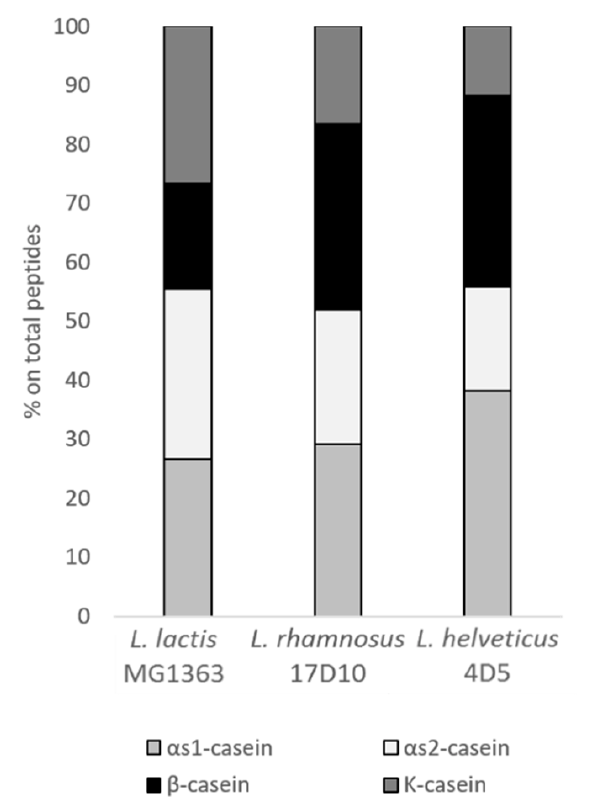
Figure 3. Percentage of casein-derived peptides harvested in the late exponential phase of L. lactis MG1363, L. rhamnosus 17D10 and L. helveticus 4D5 growth curves.